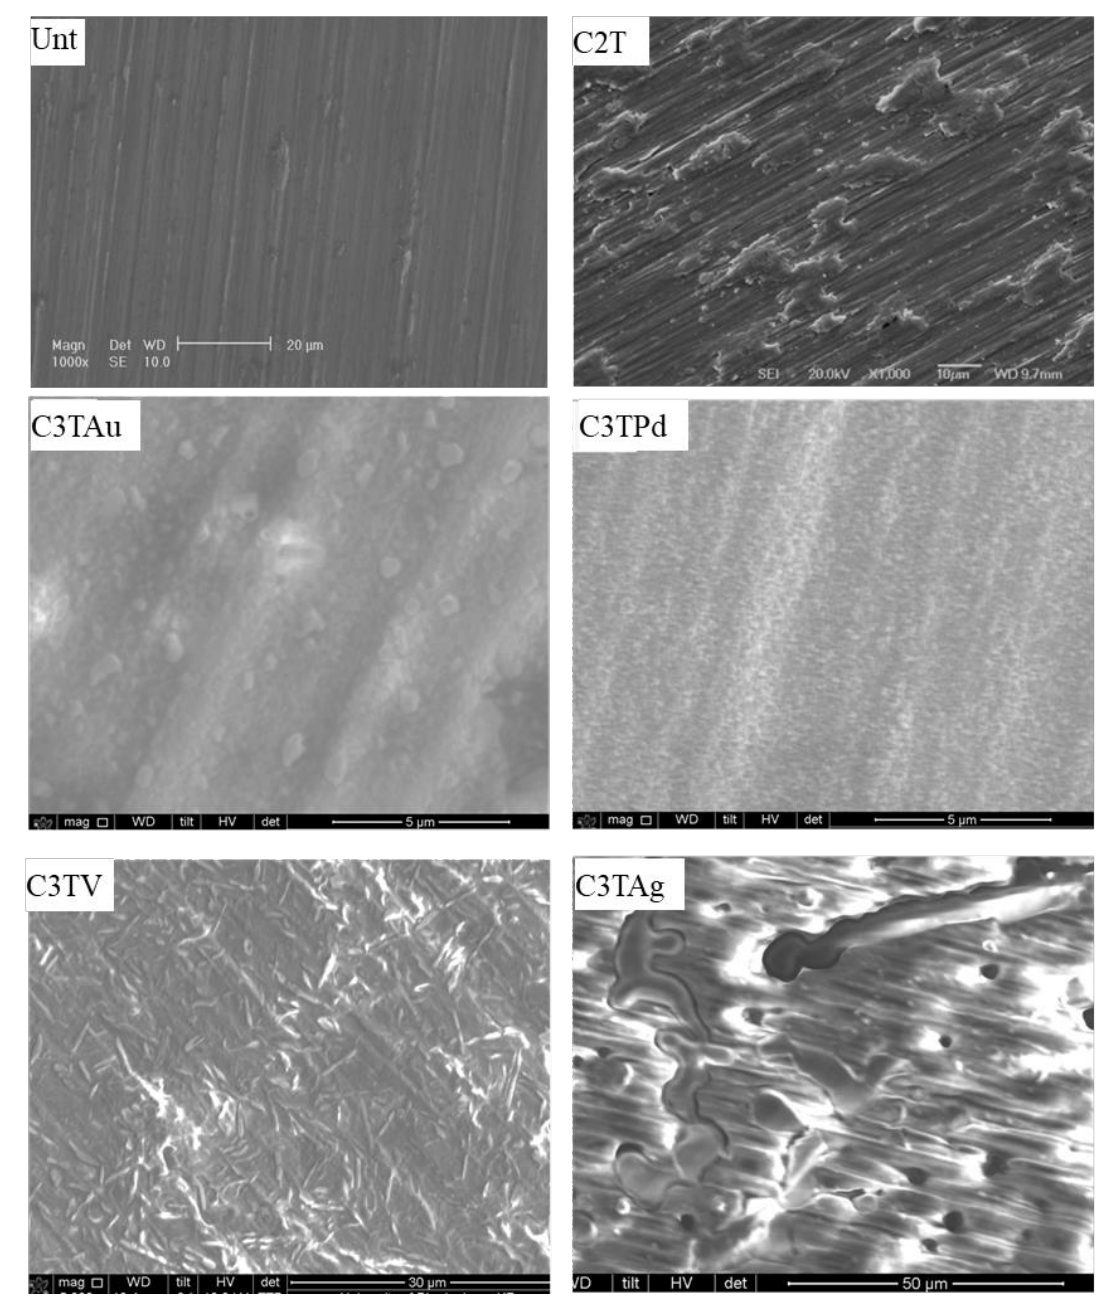
Figure 2. SEM images showing surface morphology of the samples with pre-deposited elements, as shown in the figure, after C3T at 600 °C for 10 h, compared with the untreated sample (Unt) and the sample treated with no pre-deposition layer (C2T).